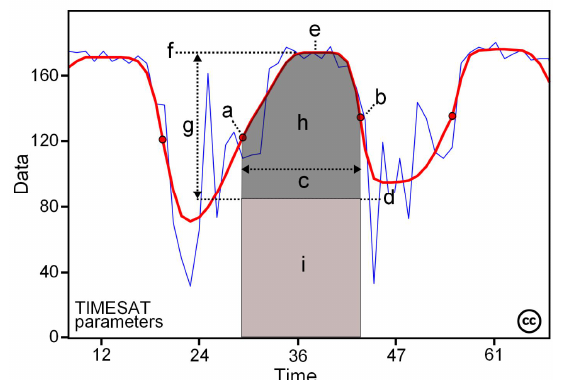
Figure 2: Seasonality parameters generated in TIMESAT: (a) beginning of season (SOS), (b) end of season (EOS), (c) length of season (LOS), (d) base value, (e) time of middle of season, (f ) maximum value, (g) amplitude (AOS), (h) small integrated value, (h+i) large integrated